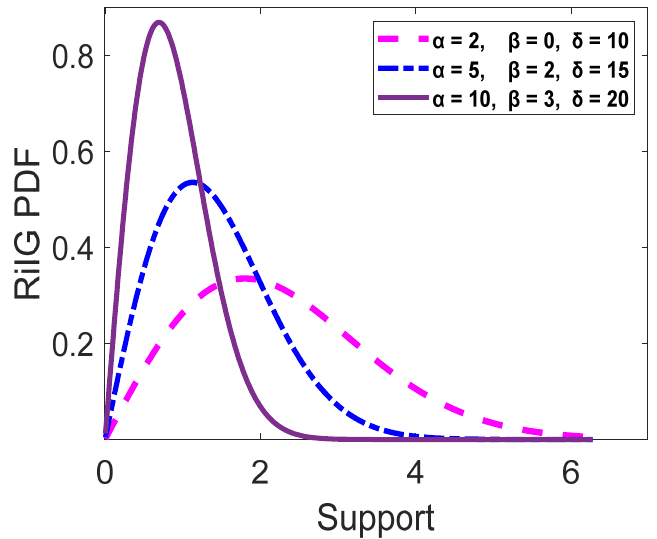
Figure 4. Examples of the PDFs residing in the RiIG model with various α , β , and δ values. The Contourlet Parametric (CP) image is constructed from the RiIG parameter ( δ ) map, which is attained by employing a square sliding window to process the